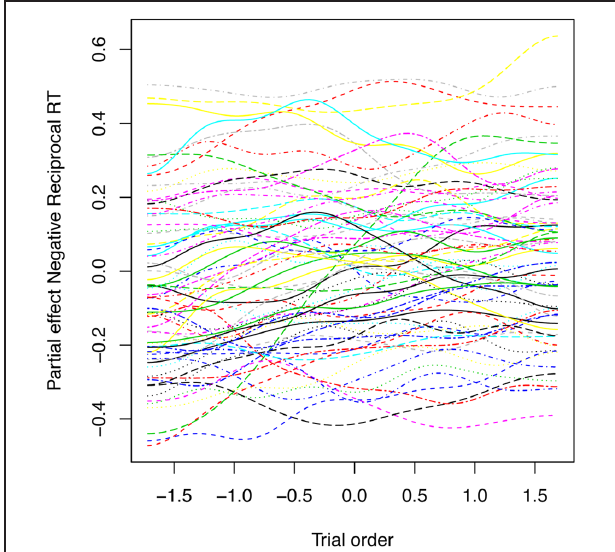
FIGURE 9 | Partial effect of the by-participant random smooths for Trial in the generalized additive mixed model fitted to the primed lexical decision latencies with a 34 ms SOA. Each curve represents a different